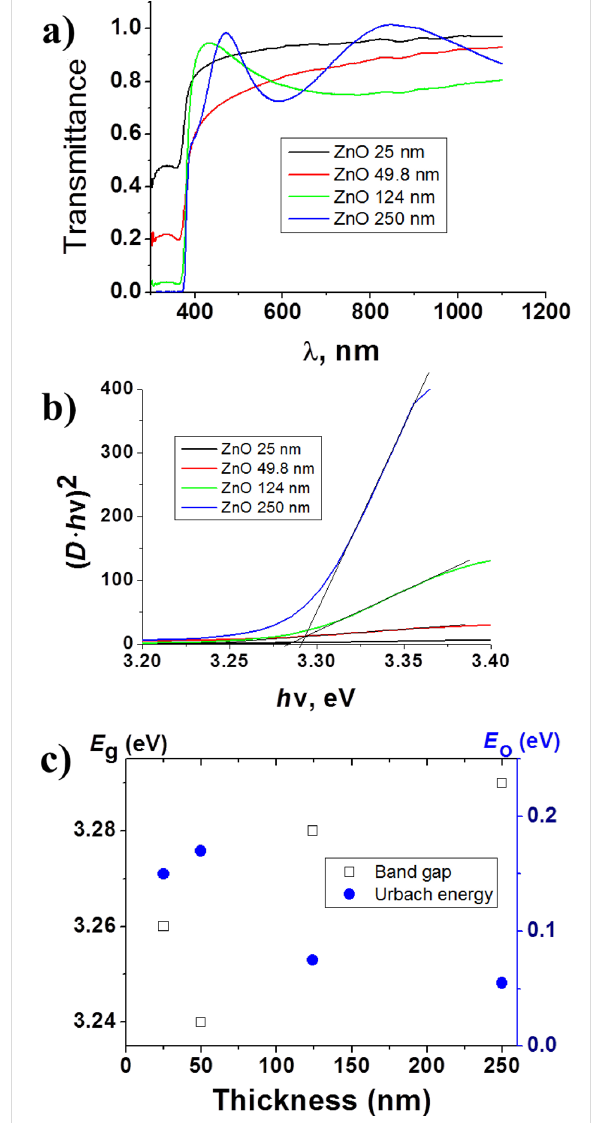
Figure 3: a) Transmittance spectra, b) band gap estimation, and c) band gap and Urbach energies of ZnO ALD films of different